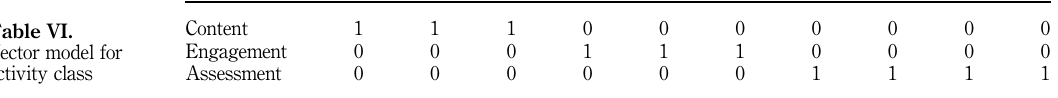
Table VI. Vector model for activity